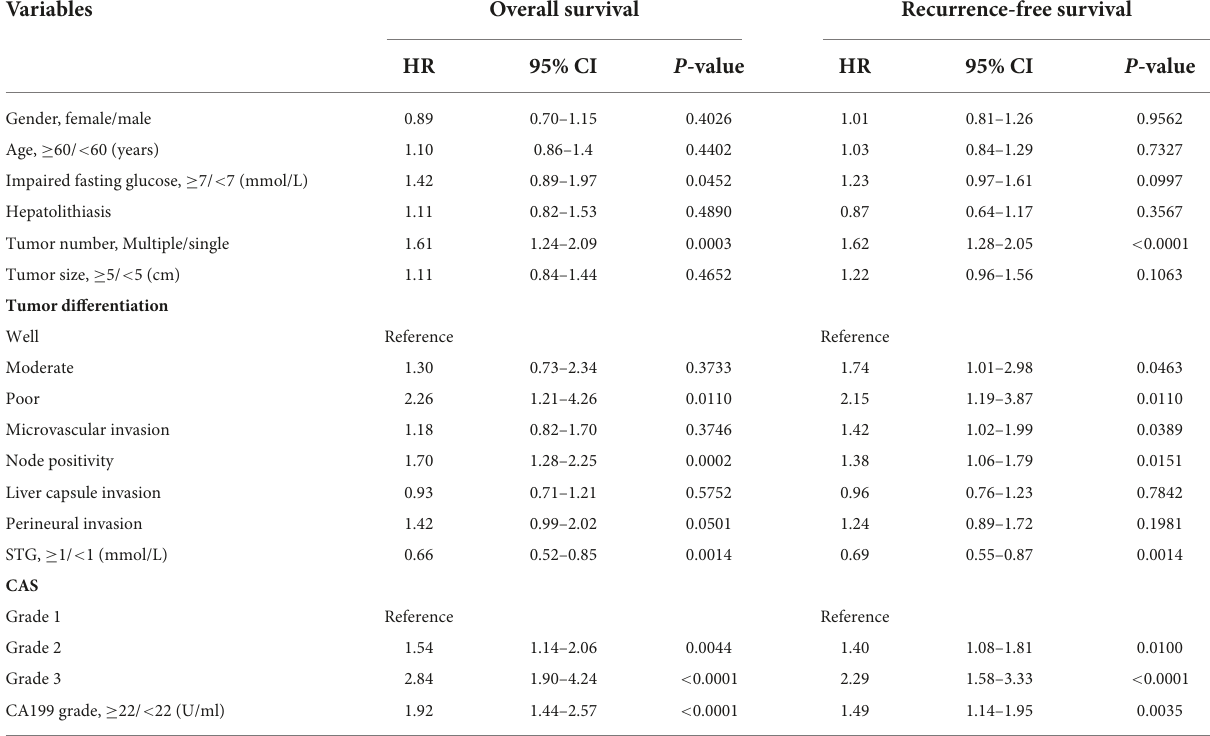
TABLE 3 Multivariate analyses to determine independent predictors of overall survival and recurrence-free survival in the discovery set.